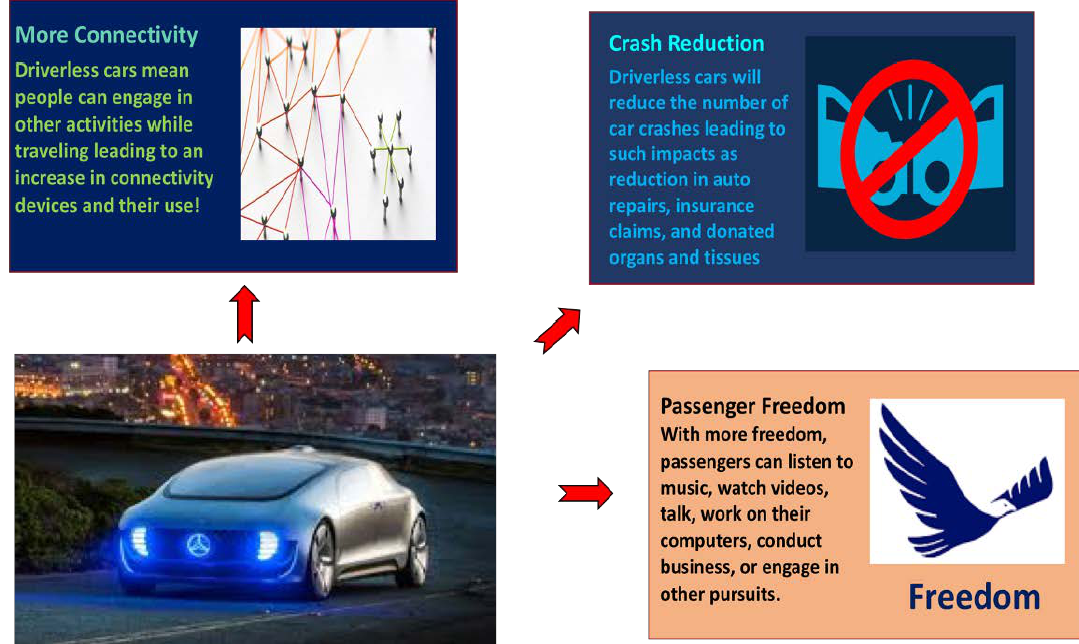
Figure 2. Adoption of autonomously driven vehicles proposes a reduction in traffic accidents, enhance connectivity for driver and passenger, and passenger freedom to pursue a range of family, leisure, and work activities.